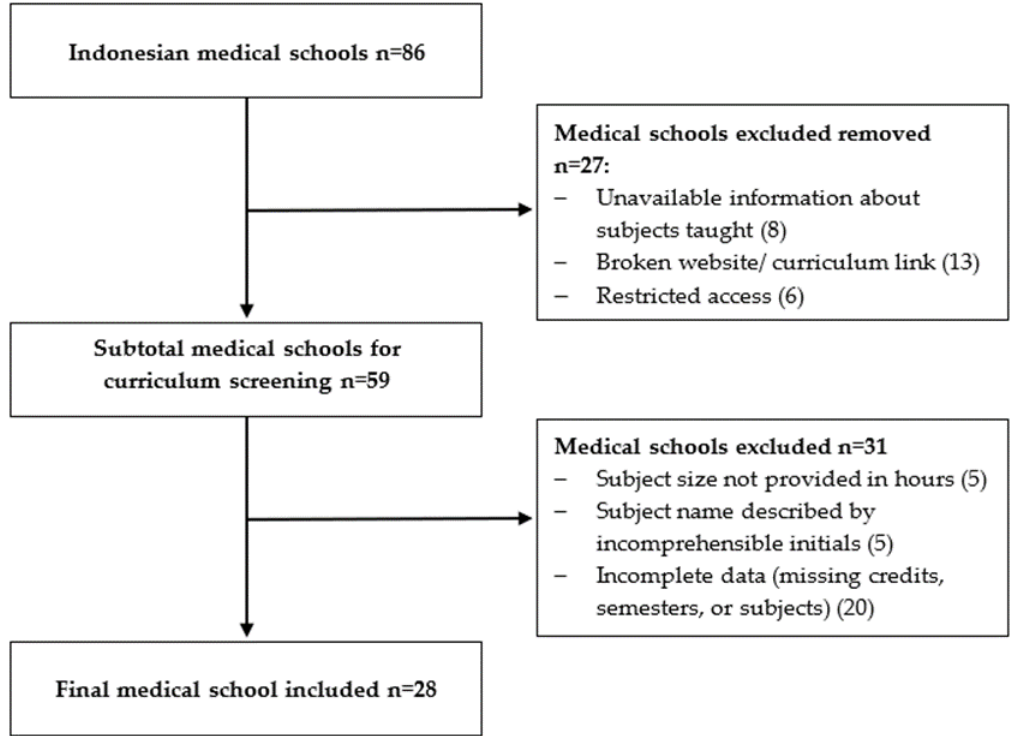
Figure 1. Flow chart of website search for information on medical degree bachelor stage subjects in the 86 Indonesian medical schools. Twenty-eight medical schools fit the inclusion criteria and were included in the